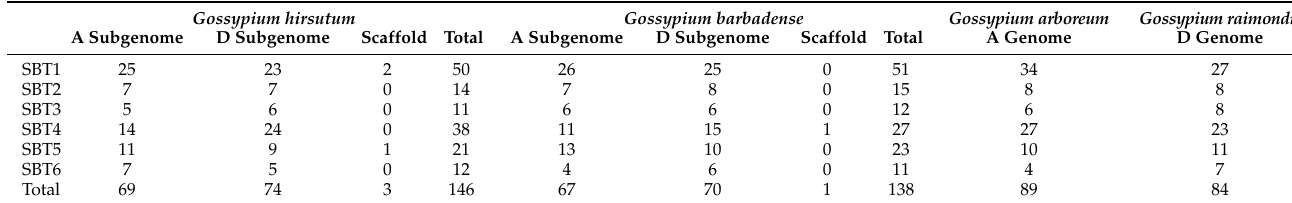
Table 1. Statistics of SBT gene family members of four cotton